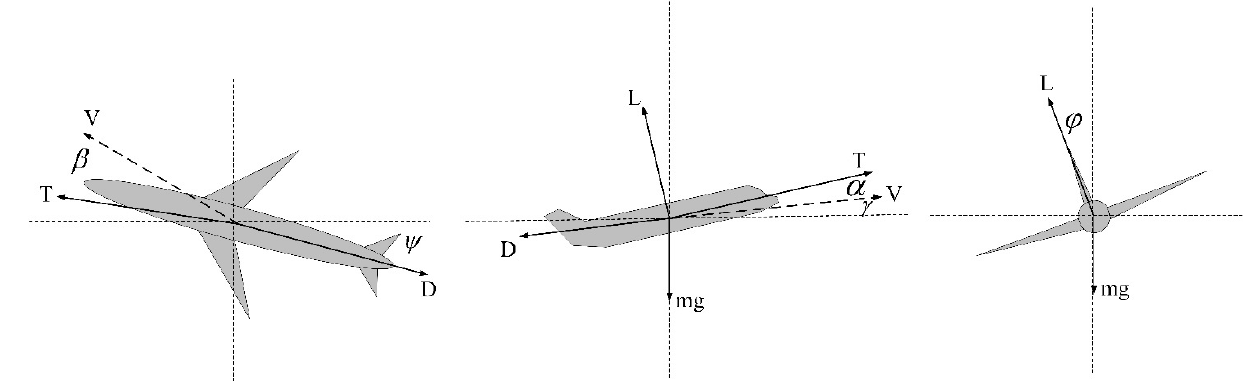
Figure 3. The free-body diagram of forces acting on the point mass.